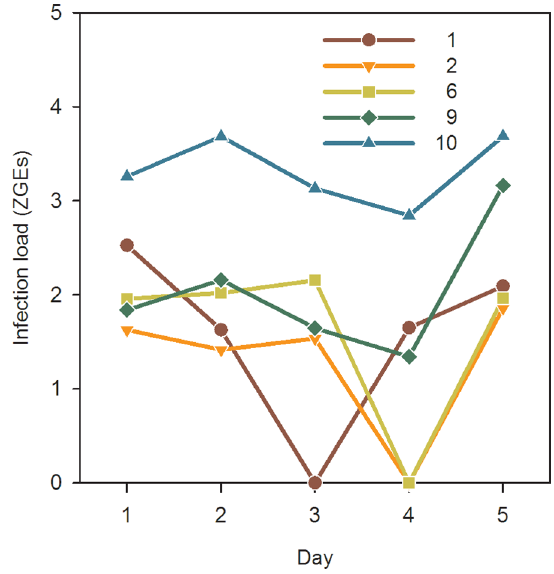
Figure 3. Zoospores released by infected subjects, represented as zoospore genomic equivalents (ZGEs), each day over a 5- day collection period. ZGEs are log-transformed. doi:10.1371/journal.pone.0111091.g003 PLOS ONE |